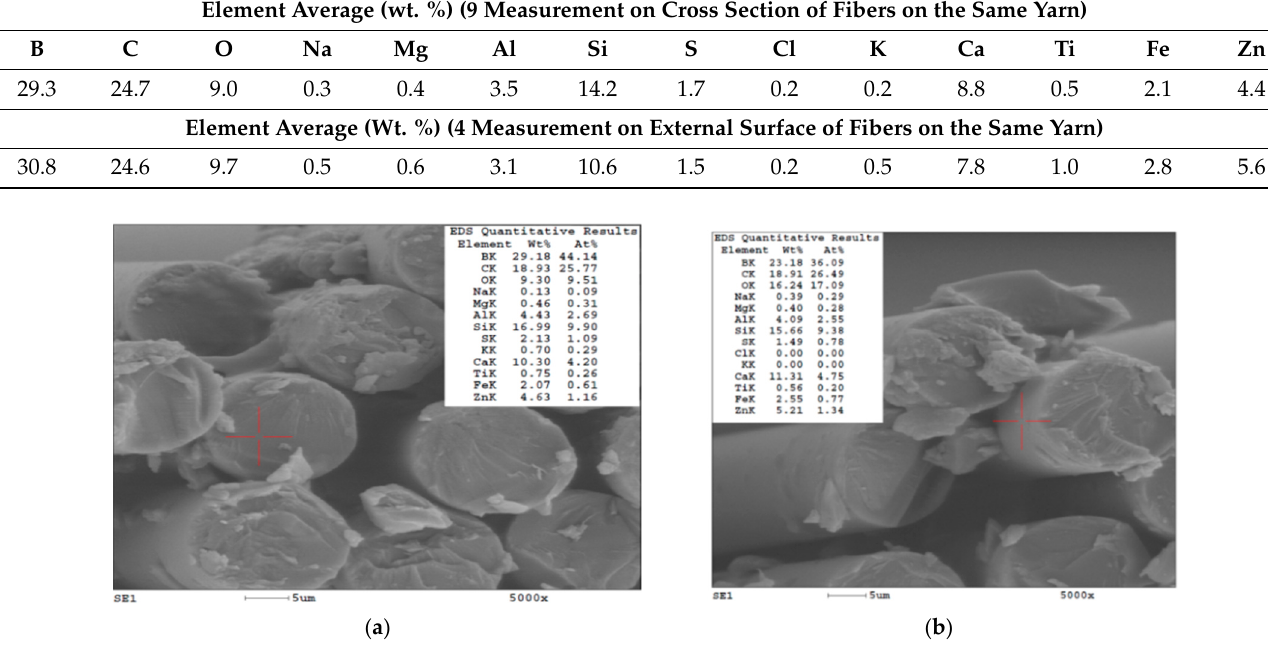
Figure 1. EDS elemental analysis of a glass fiber (red cross indicates the analyzed point). ( a ) Glass fiber core (cross section). ( b ) Glass fiber jacket. Table 2. Elemental analysis (EDS) of the glass fibers [34].